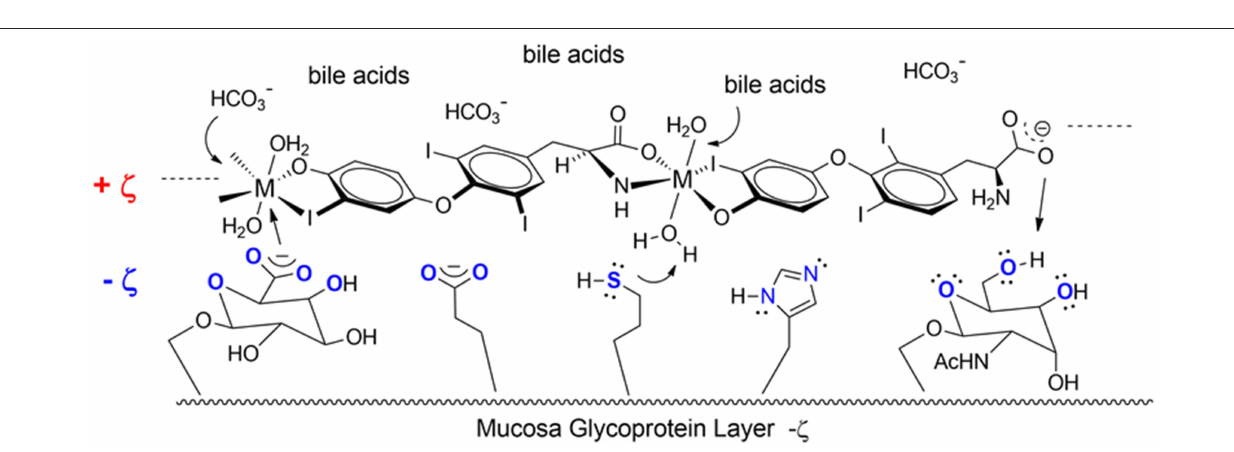
the peaks of T3 in the circulation will inevitably remain (37).